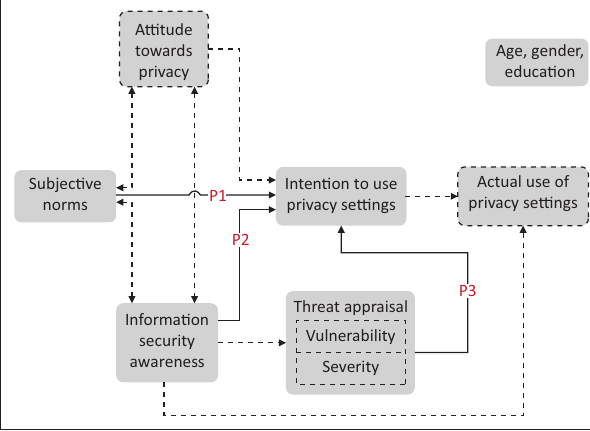
FIGURE 3: Proposed research